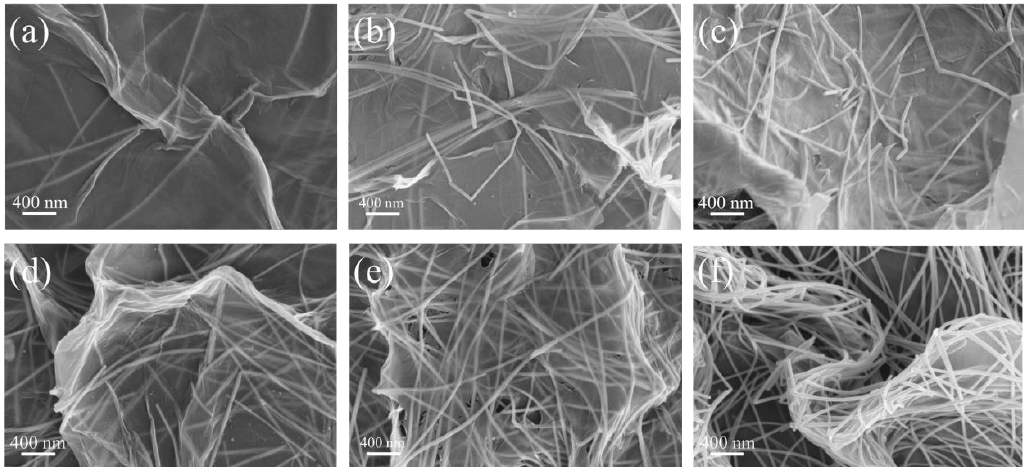
Figure 3. SEM images of the AgNW/GO hybrid with different percentages of AgNWs: ( a ) 15 wt.%, ( b ) 30 wt.%, ( c ) 45 wt.%, ( d ) 60 wt.%, ( e ) 75 wt.%, and ( f ) 90 wt.%.